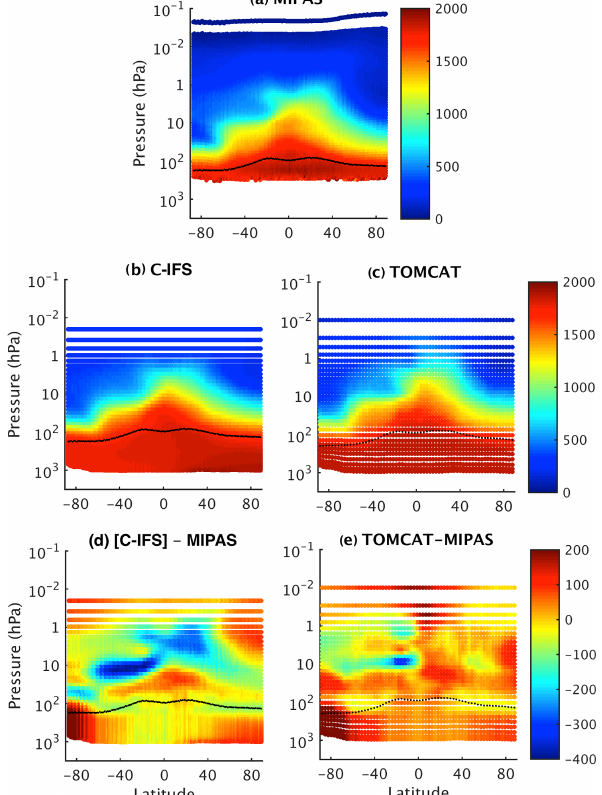
Figure 5. Zonal mean latitude–pressure plots of CH 4 (in ppb) for the months September to November 2010. Panel (a) shows the pro- files from the MIPAS satellite soundings. Panels (b) and (c) show the profiles from the C-IFS and TOMCAT models, respectively, sampled at the location and time of the MIPAS measurement. Panels (d) and (e) show the bias between the models and MIPAS measure- ments. The tropopause location is shown as black dots.